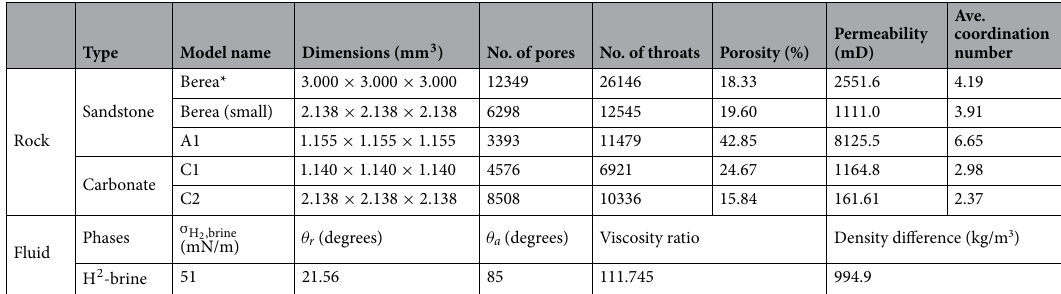
Table 5. Fluid and rock properties for studying the effect of rock structure on the upscaled transport functions. *Indicates the base-case